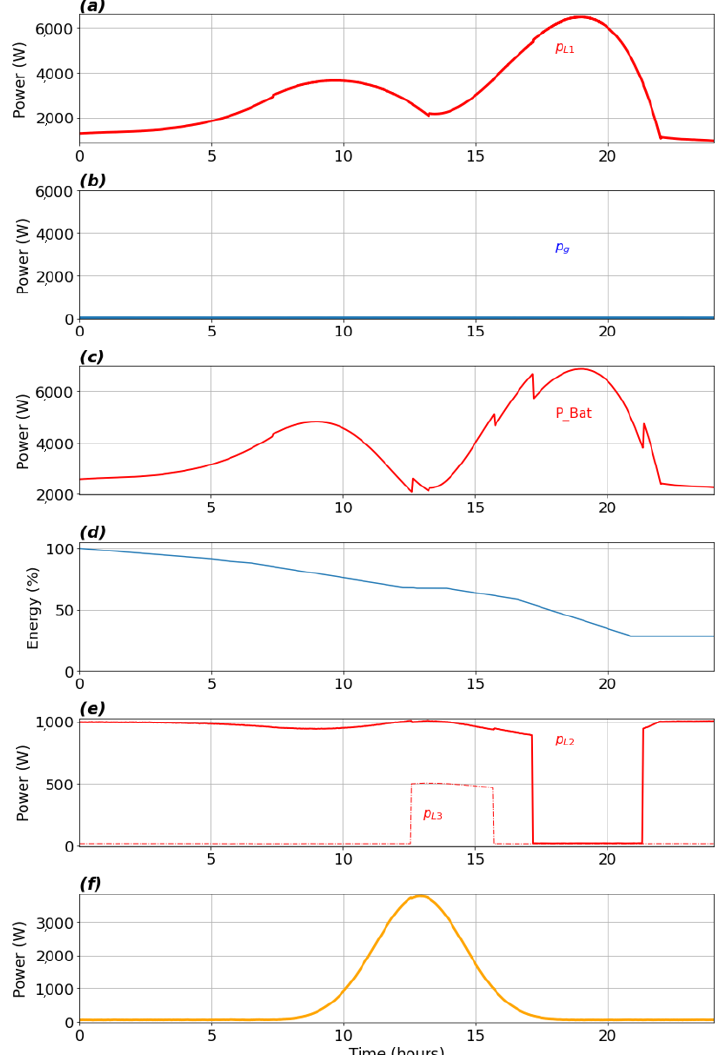
Figure 27. MG operating in islanded mode with active power consumption. Power values: ( a ) Main load active power; ( b ) Main grid power; ( c ) Battery bank active power; ( d ) Battery storage level; ( e ) Load 2 and 3 active power; ( f ) Photovoltaic active power. The bus active power in this scenario determines the voltage level, as Figure 28b shows, and the energy prices (a) for sale and purchase, as well as the control signals, are sent (c–e) from the controller to the connection